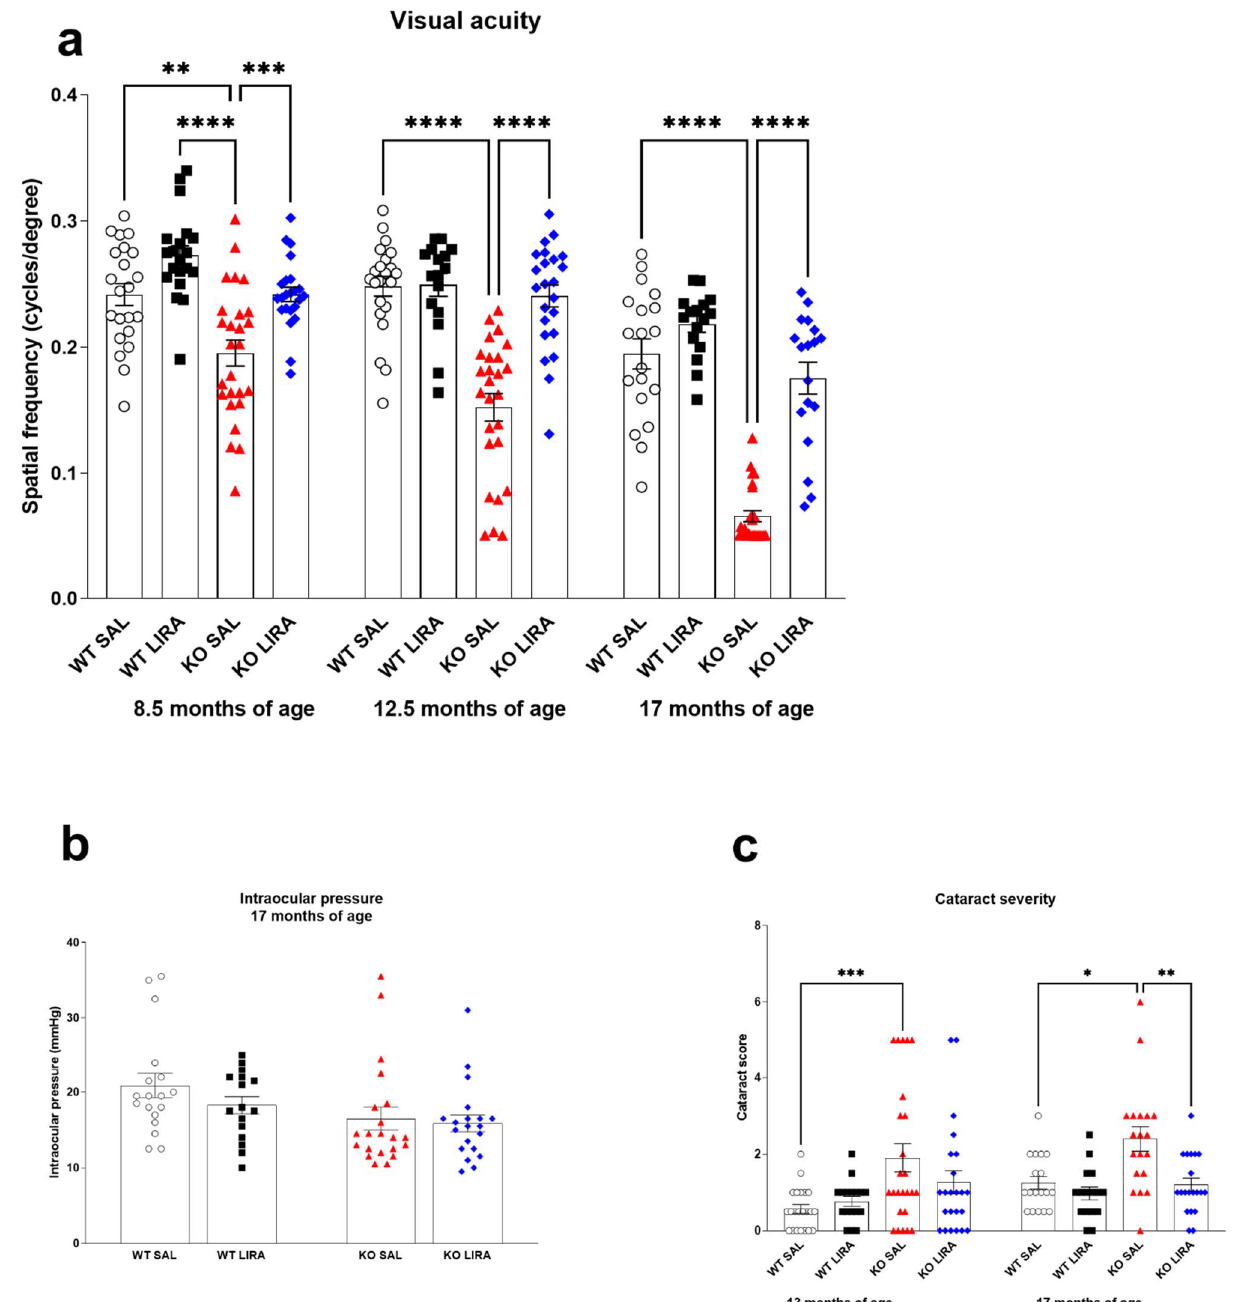
Figure 4. A 16-month treatment with GLP1 receptor agonist liraglutide protects against vision loss in a rat model of Wolfram syndrome. ( a ) Optokinetic reflex response at the age of 8.5, 12.5 and 17 months. Response was measured for both eyes and the data were averaged. In KO SAL animals, visual acuity decreased over time, while in KO LIRA animals, visual acuity stayed at the same level as WT SAL animals. ( b ) Intraocular pressure at the age of 17 months was unchanged between experimental groups, the data were compared using one-way ANOVA followed by Tukey’s multiple comparisons test. ( c ) Cataract severity at the age of 13 and 17 months. The data were compared using two-way ANOVA followed by Tukey’s multiple comparisons test. The data are presented as the mean ± SEM, * p < 0.05, ** p < 0.01, *** p < 0.001, **** p < 0.0001, n = 16–24 per group.